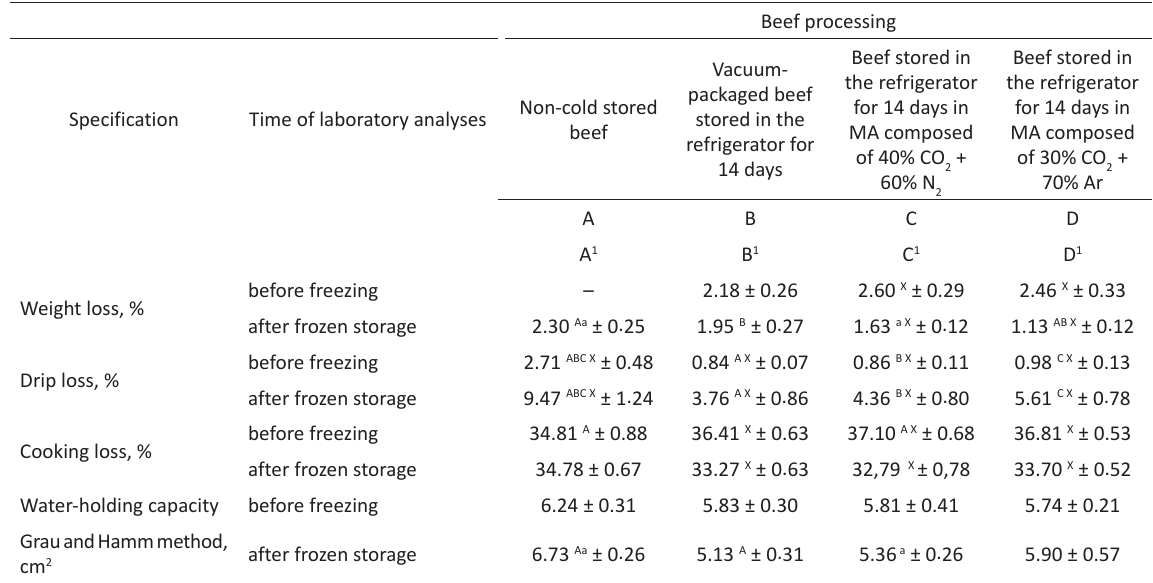
Table 1. Weight loss and water-holding capacity of meat